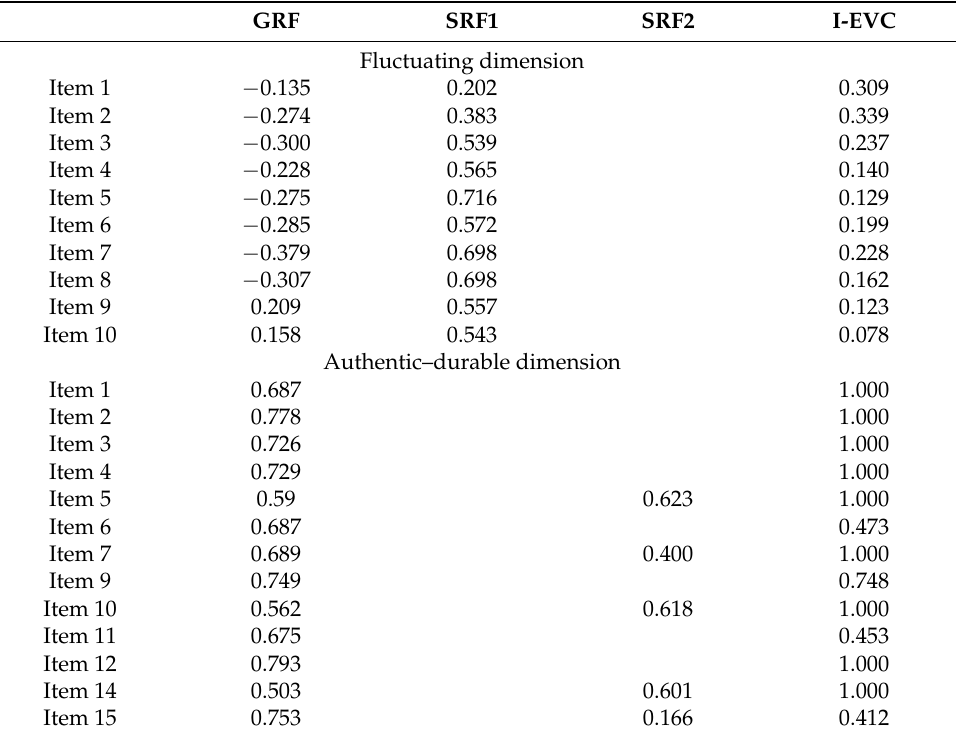
Table 3. Standardized loadings factor of bifactor confirmatory factor analysis for the general latent trait (GRF) and its specific residual latent traits.